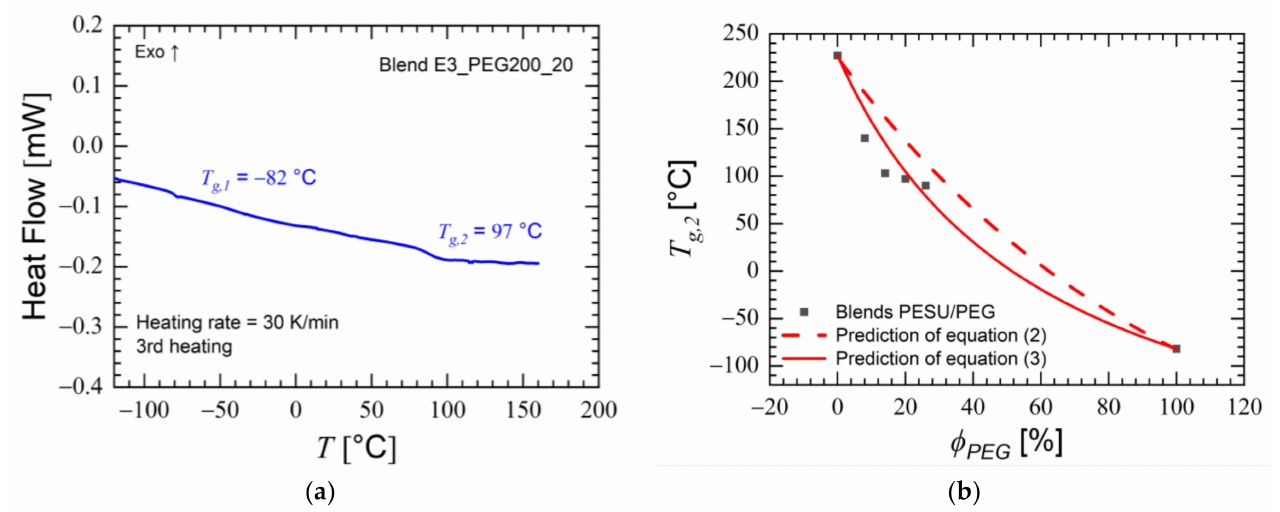
Figure 5. ( a ) Heat flow measured using differential scanning calorimetry (DSC) during the third heating cycle of blend E3_PEG200_20 showed the occurrence of two glass transitions; ( b ) observed second glass transitions ( T g,2 ) of PESU/PEG blends versus weight percentage of PEG and the predictions from Equations (2) and